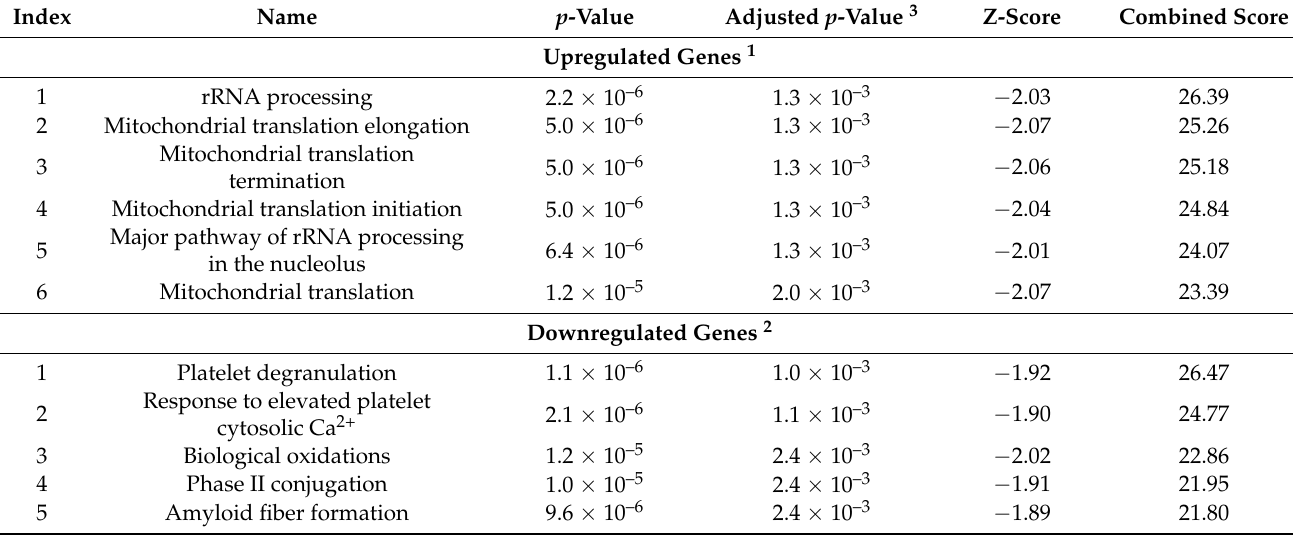
Table 1. Reactome pathway analysis in sorafenib-resistant Huh7